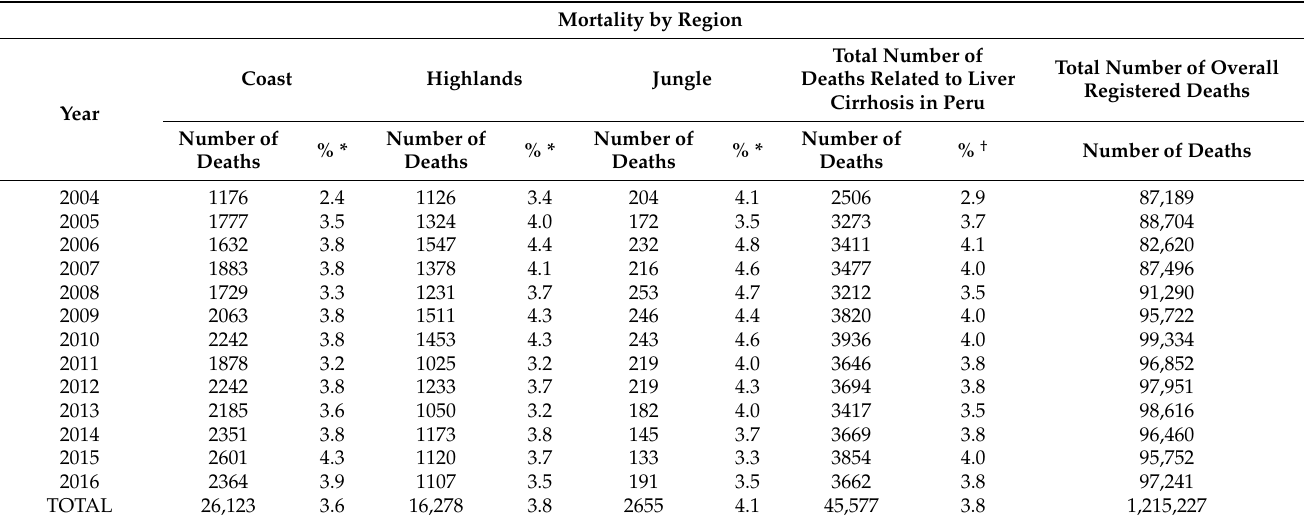
Table 3. Mortality and complications related to liver cirrhosis according to region and the registered year of death for the period